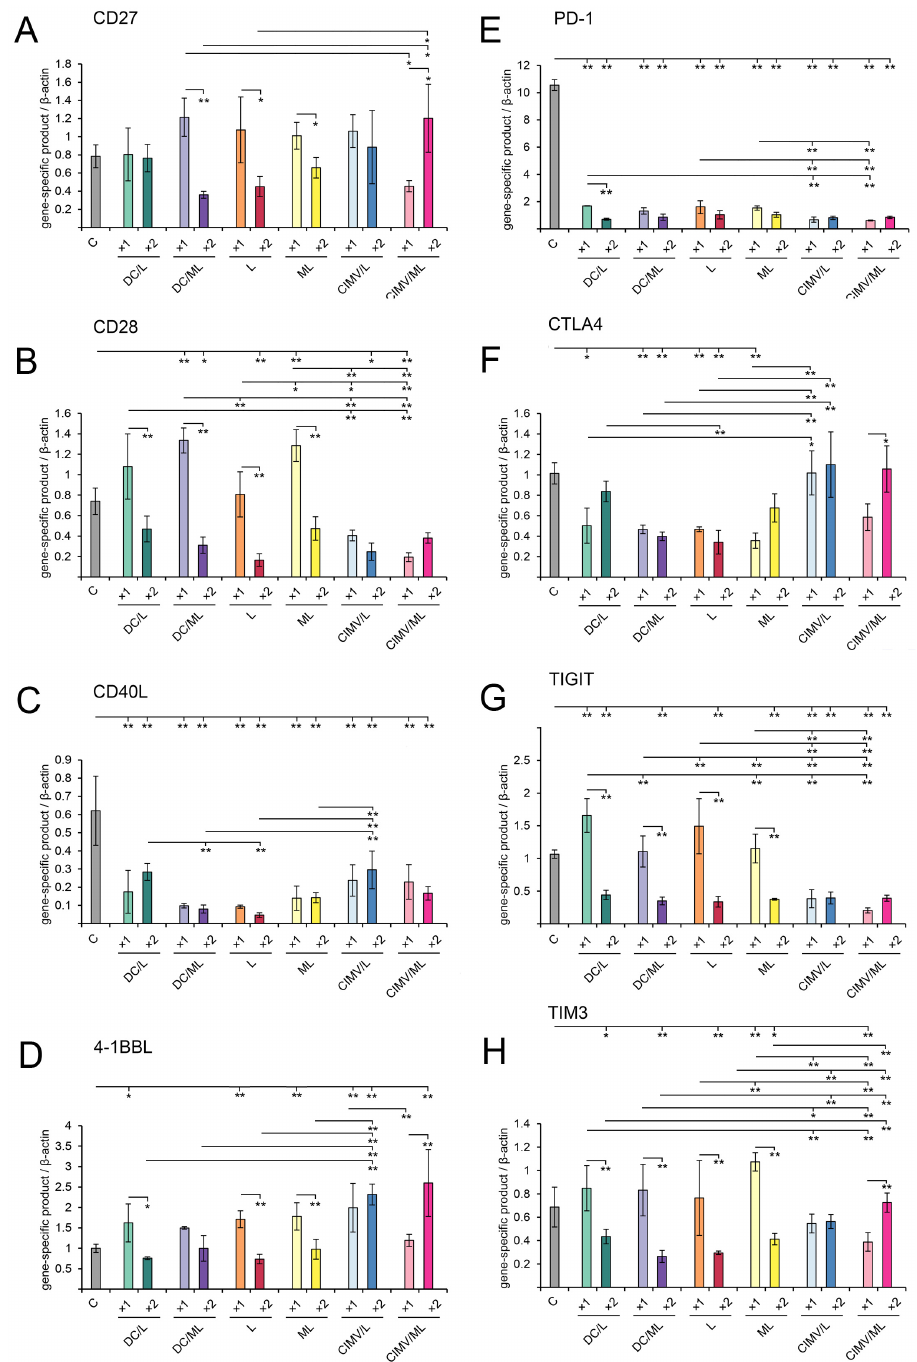
Figure 7. The expression levels of positive ( A – D ) and negative ( E – H ) immune checkpoints in splenocytes of mice with RLS 40 after immunization with DC-based or cell-free vaccines determined by qPCR and TaqMan probes. The expression level of gene-specific product was normalized to the expression level of β -actin. The expression levels of genes are presented for the 21st day after tumor implantation. Data are presented as mean ± S.E.M. Data were statistically analyzed using one-way ANOVA with post-hoc Tukey test. Statistically reliable differences between the groups: * p < 0.05, ** p < 0.01.